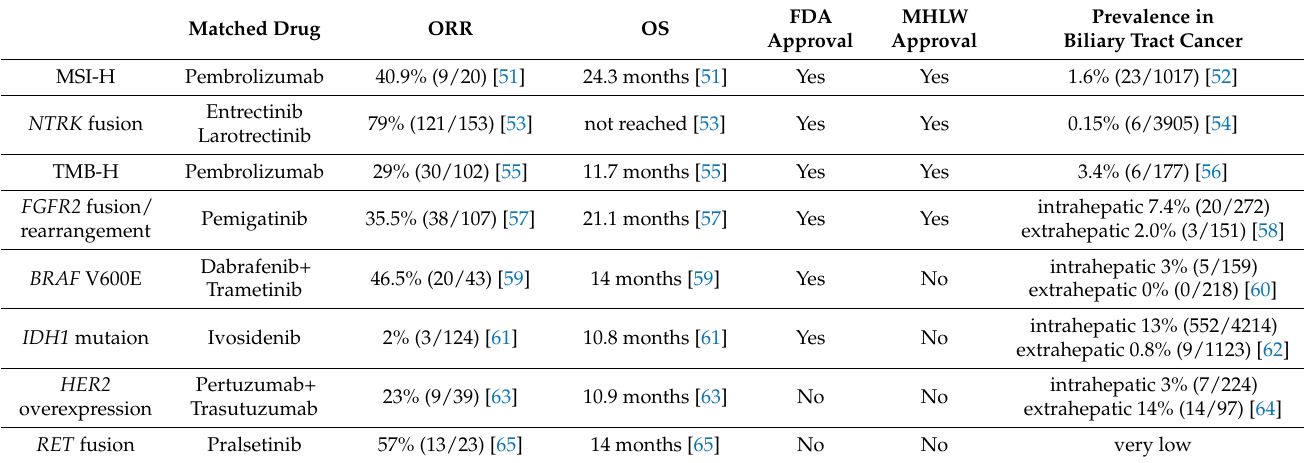
Table 2. Druggable markers listed in NCCN